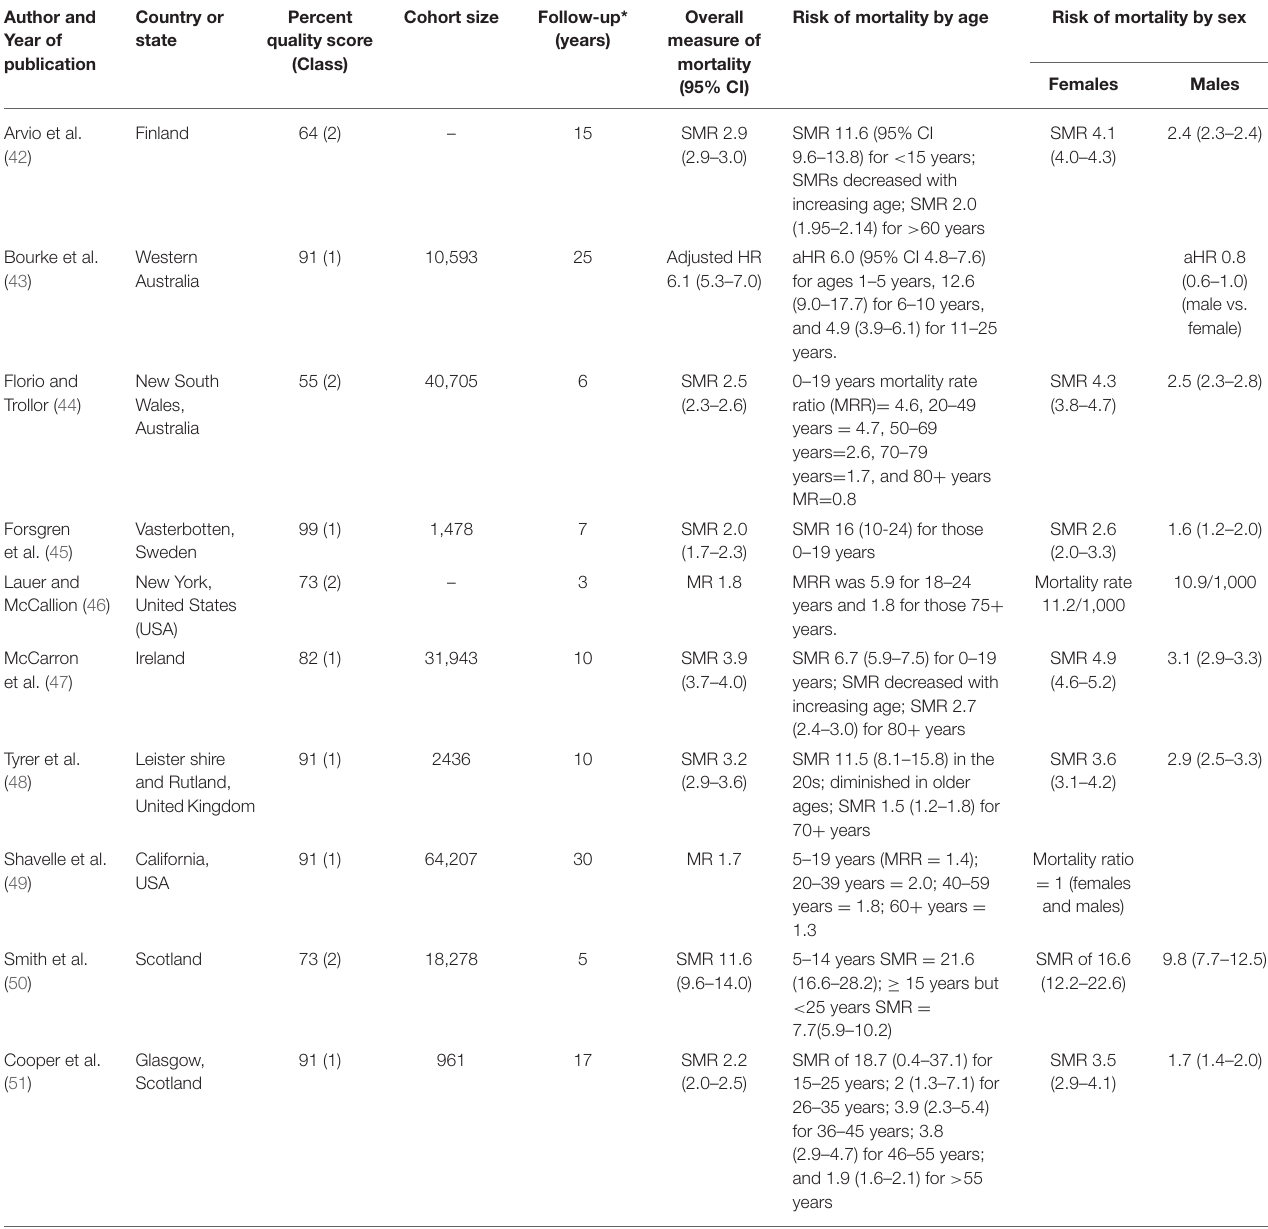
TABLE 4 | General study characteristics, overall risk, and sociodemographic risk factors for mortality in people with intellectual